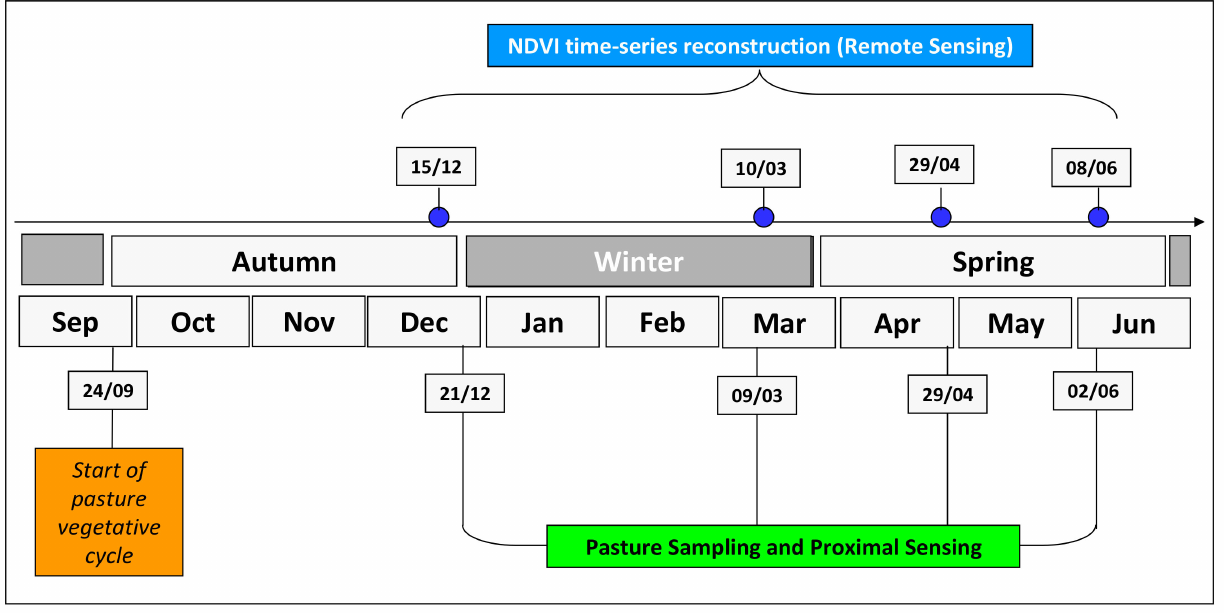
Figure 4. Chronological diagram of data collection carried out during the vegetative cycle of